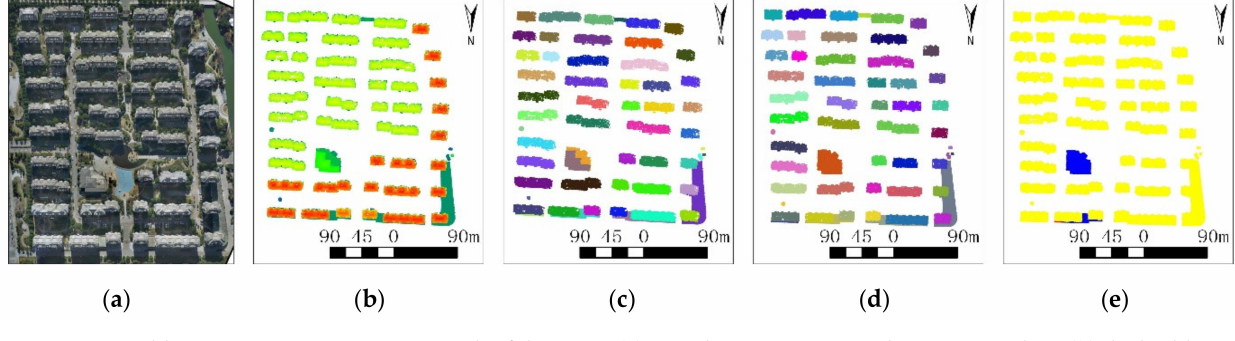
Figure 9. Building instance segmentation result of dataset 2: ( a ) Aerial image corresponding to input data; ( b ) the building point clouds; ( c ) the result of UBIS method; ( d ) the ground truth; ( e ) the main differences between the UBIS method result and the ground